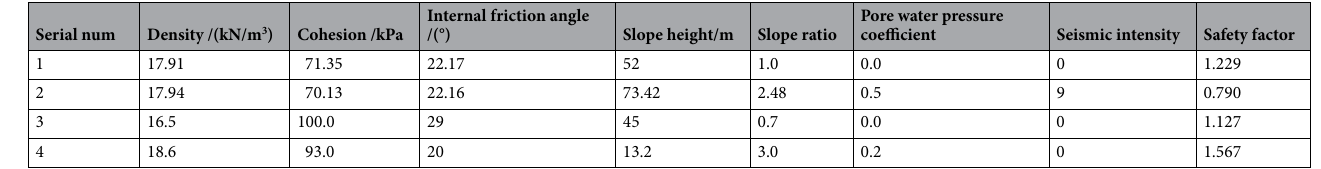
Table 4. Parameters of four new loess slope samples.